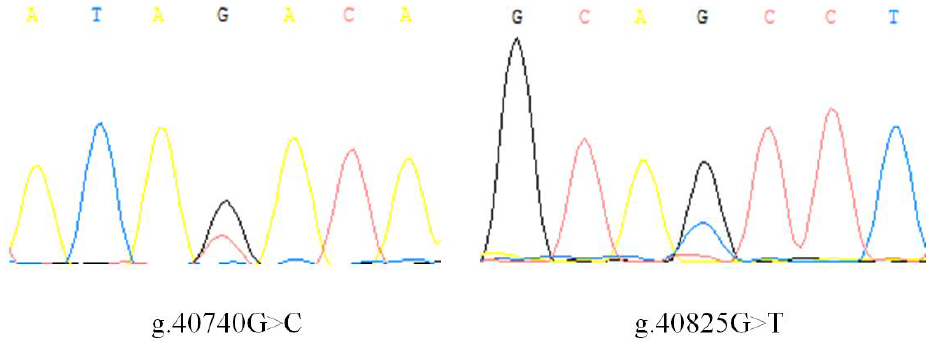
Figure 1. Sequencing results of PCR products from the DNA pool of the Shitou goose.